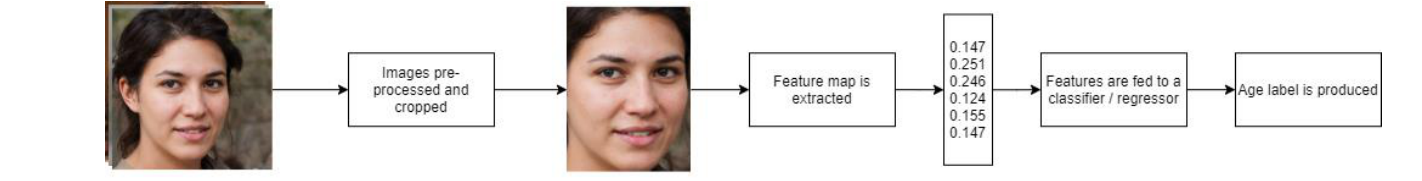
Figure 1. Overview of training a typical age estimation model.